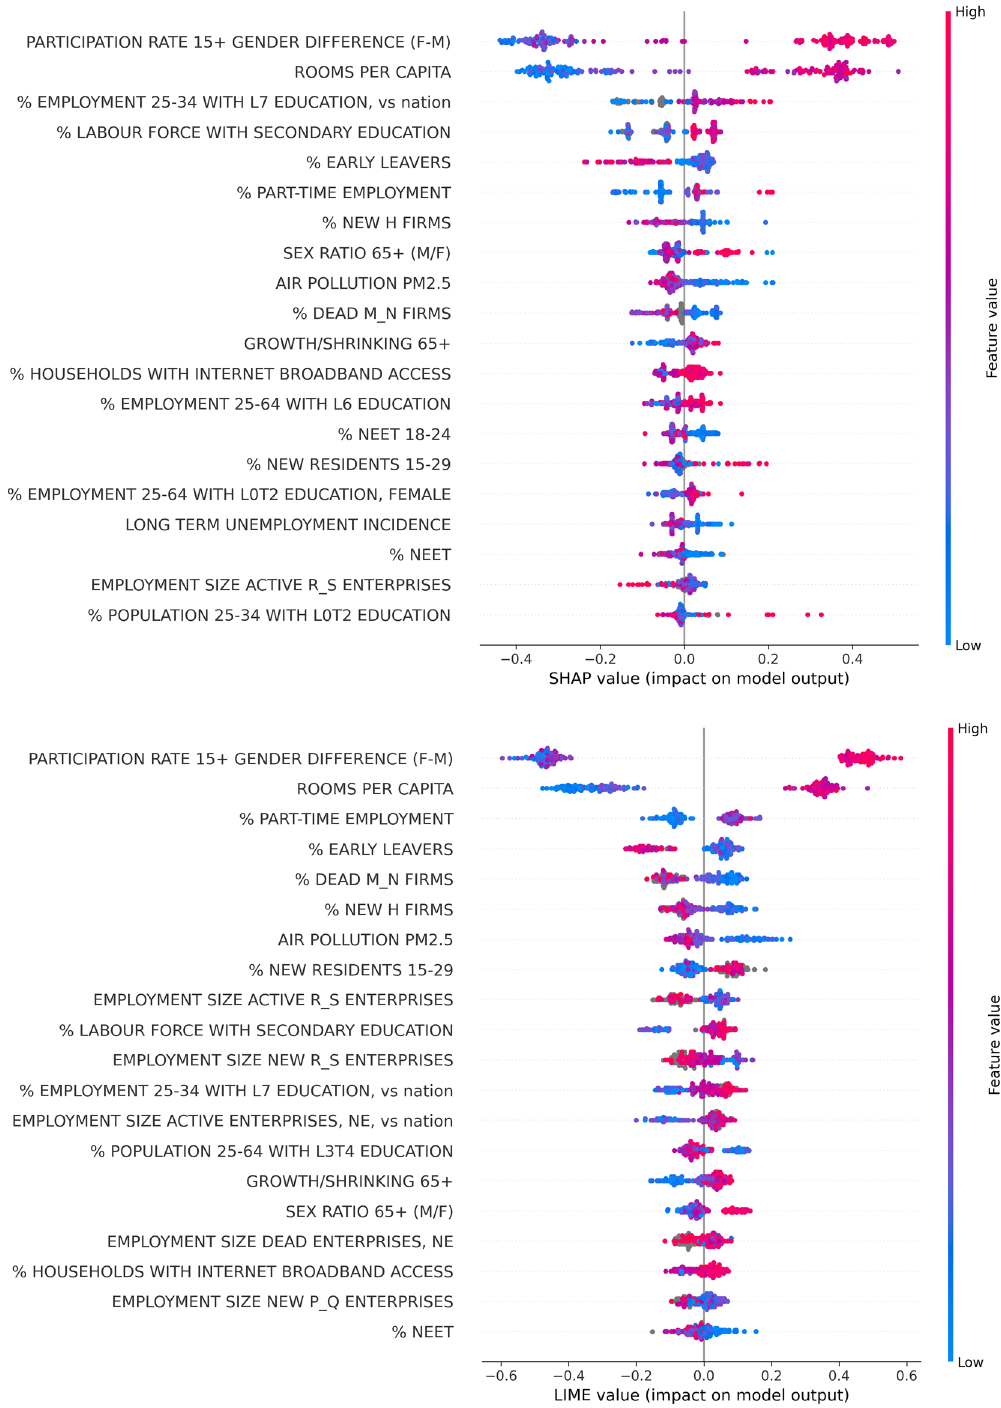
Figure 3. SHAP (upper panel) and LIME (lower panel) values corresponding to the most influential OECD indicators in the XGBoost prediction of EQI. In both plots, indicators are listed in descending order of mean absolute values of the corresponding SHAP and LIME, respectively. The definition of indicators is reported in the Supplementary Data S1–S4. The results highlight the large impact on EQI prediction of the difference between female and male labour participation rates for citizens over the age of 15 and the average number of rooms per